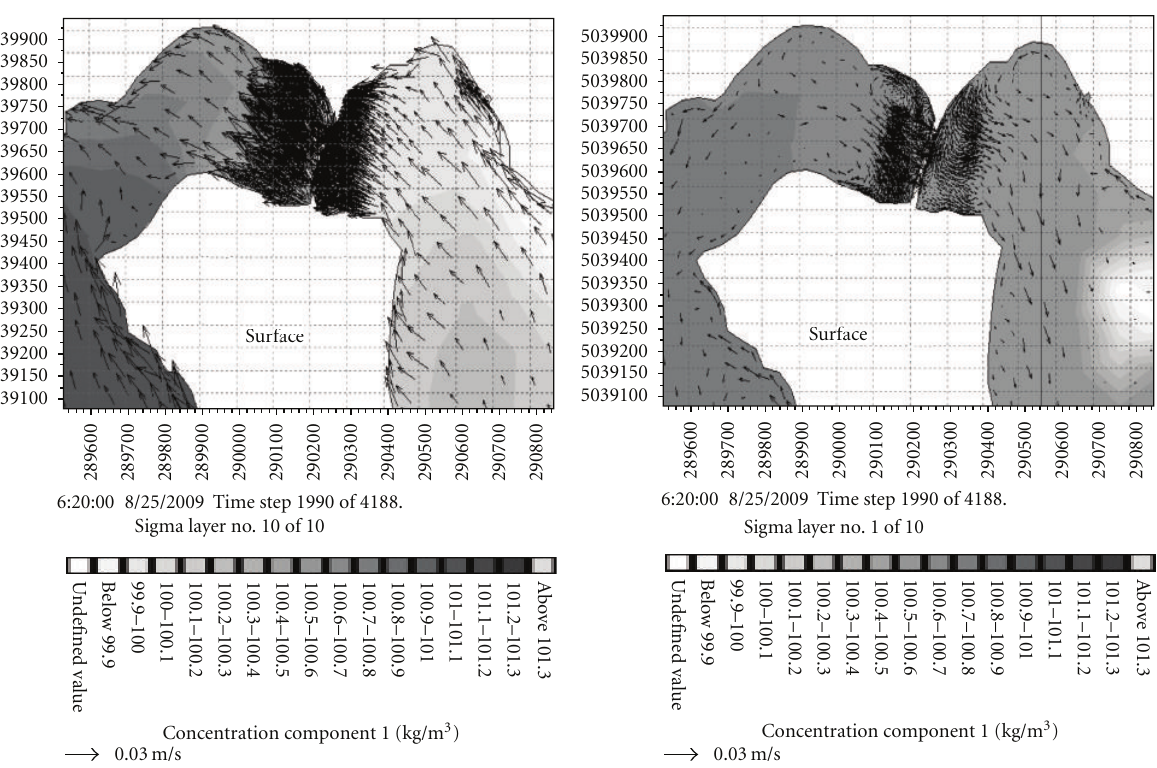
Figure 23: The simulated surface and bottom flow patterns for the causeway with 4 and 5 culvert configurations.